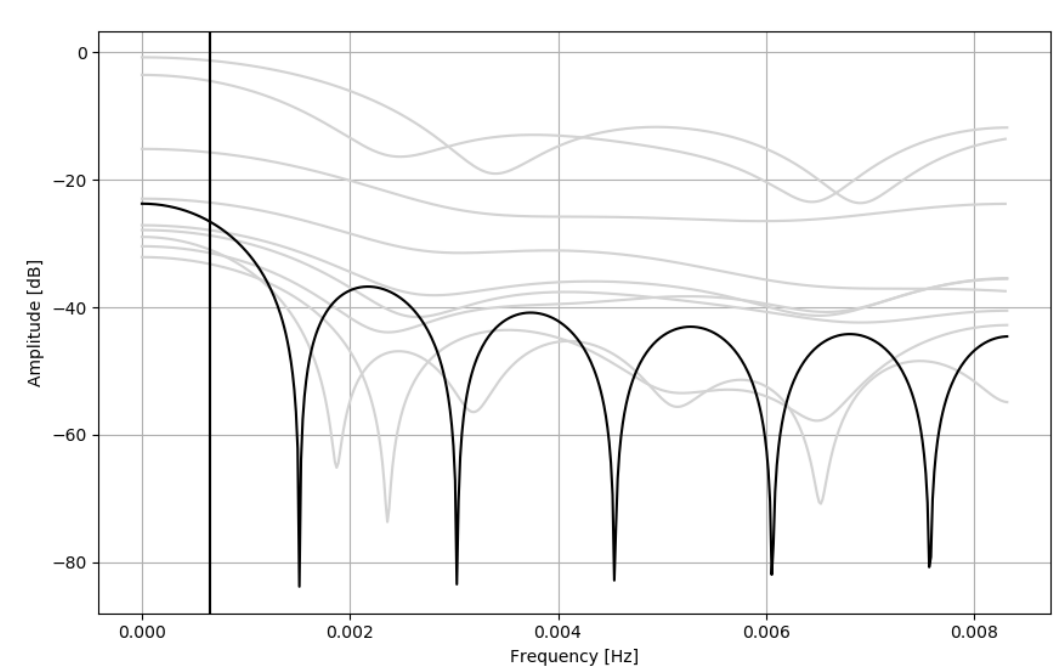
Figure 2. Transmittance of the FIR filter representing Sadeh 1994 linear terms of the equation (black), compared to the transmittances of the other algorithms discussed in this study (grey), the same as Figure 1. Cutoff frequency: 0.00065 Hz (period: 25 min 40